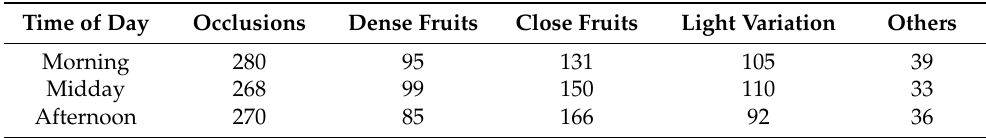
Table 1. Image dataset information under different